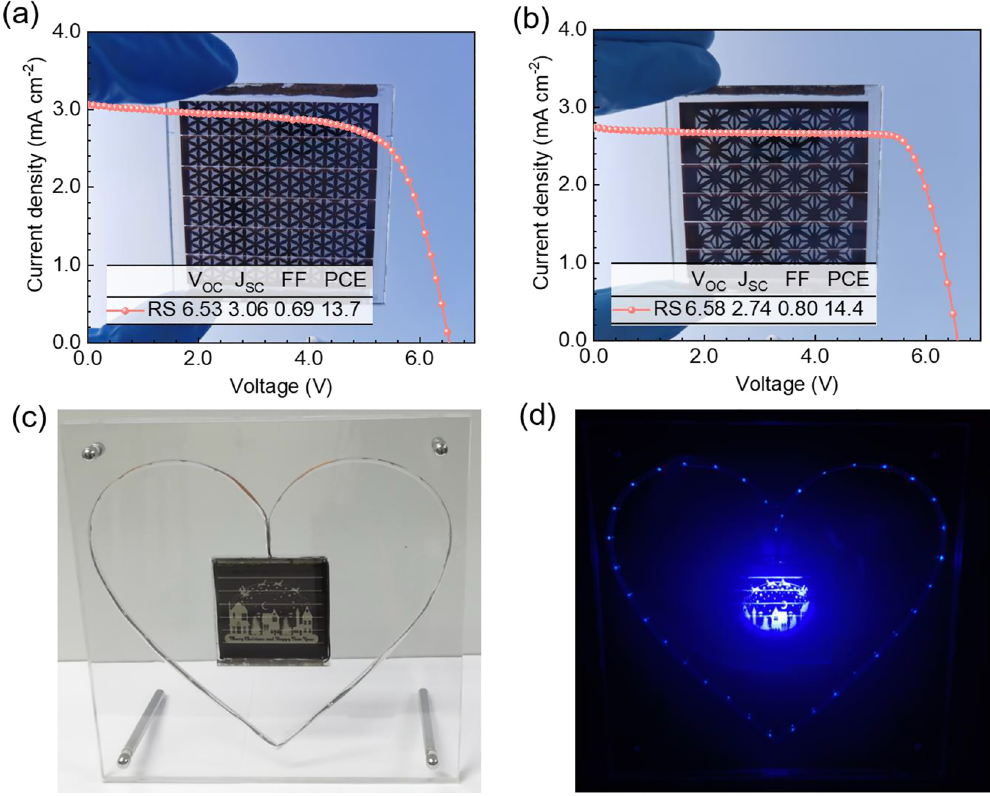
Figure 5: Photovoltaic performance characterizations of rationally designed patterned PSCs. Current − voltage characteristics of PSCs imprinted with (a) origami and (b) symmetrical fl owers patterns. (c) and (d) Photo of a PSC Christmas card and lightening more than 35 LEDs under the irradiation of a low intensity dark blue LED